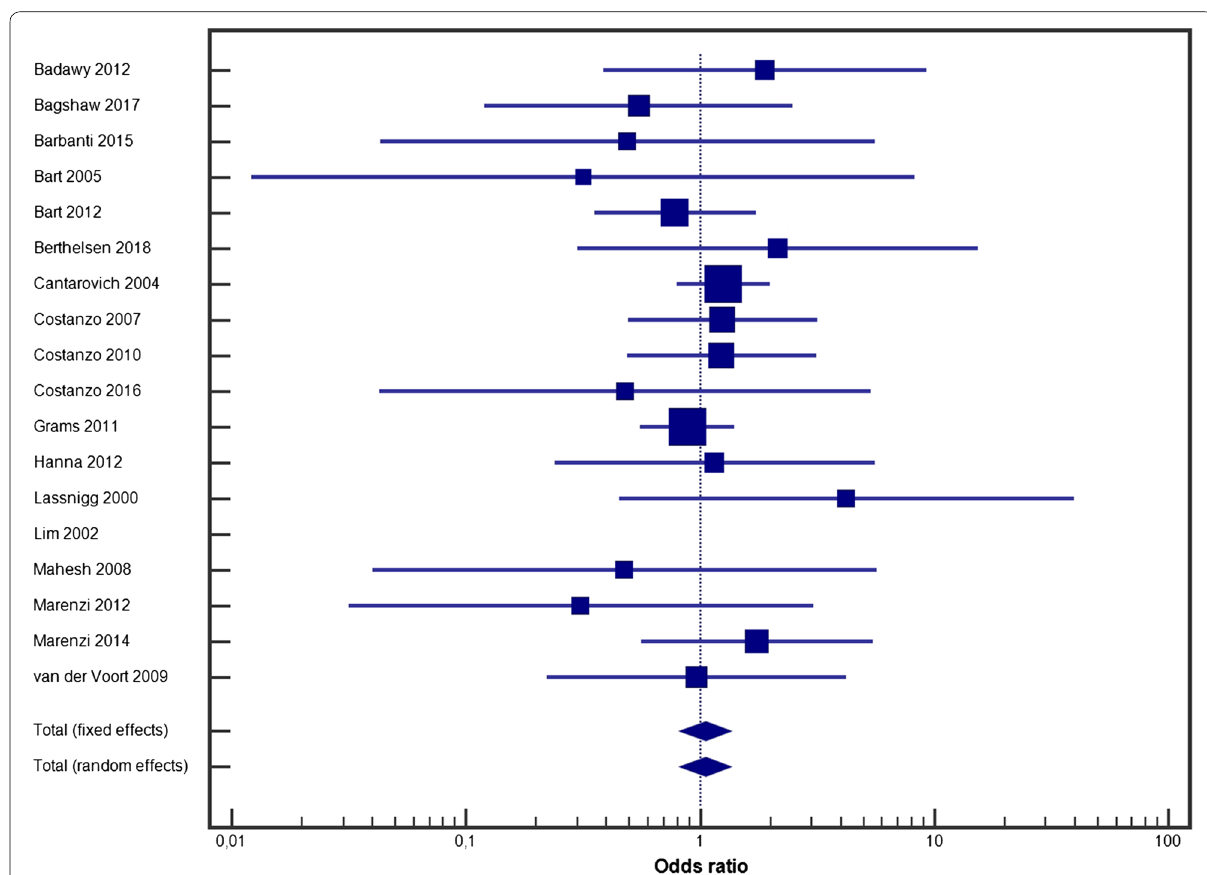
Fig. 2 Forest plot for furosemide use and